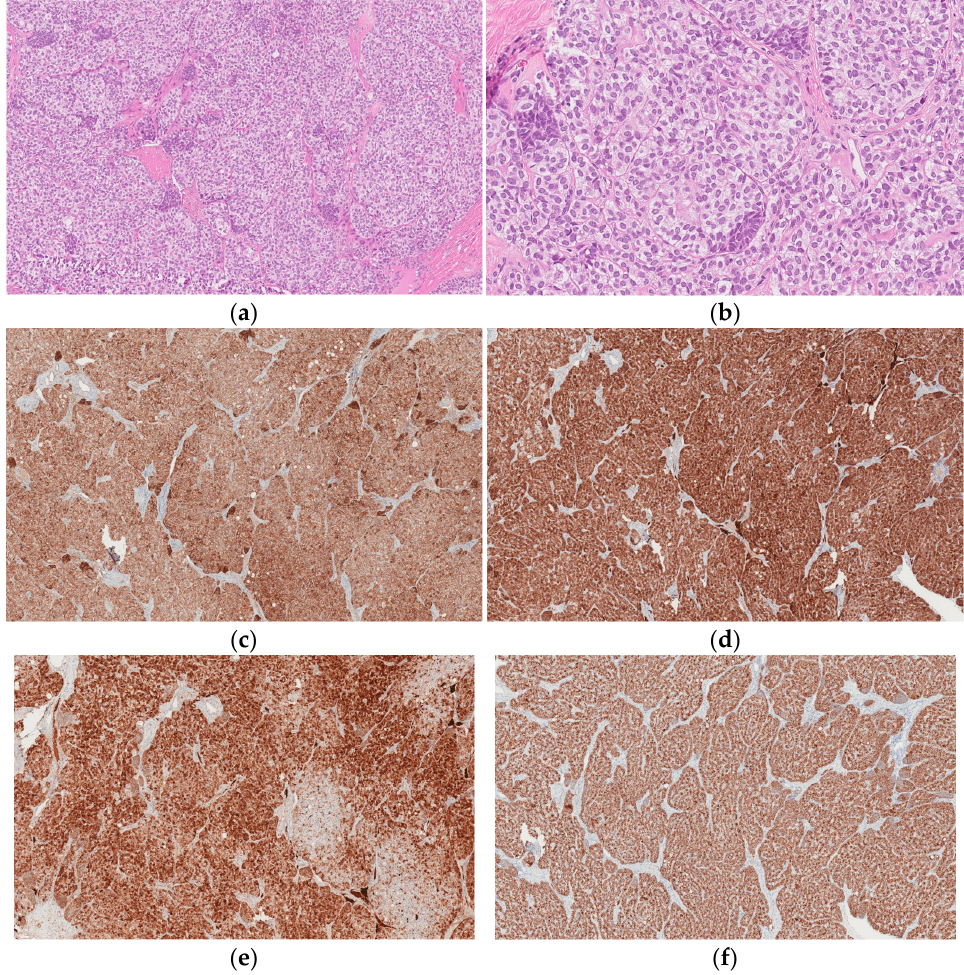
Figure 2. ( a ) Low-power view: solid tubules and trabecular structures composed of cells in hyalinized stroma with intervening small nests formed of cells with scant eosinophilic cytoplasm and hyper- chromic, slightly irregular, and angular nuclei. ( b ) High-power view: small nests formed of cells with scant eosinophilic cytoplasm and hyperchromic, slightly irregular, and angular nuclei. ( c )